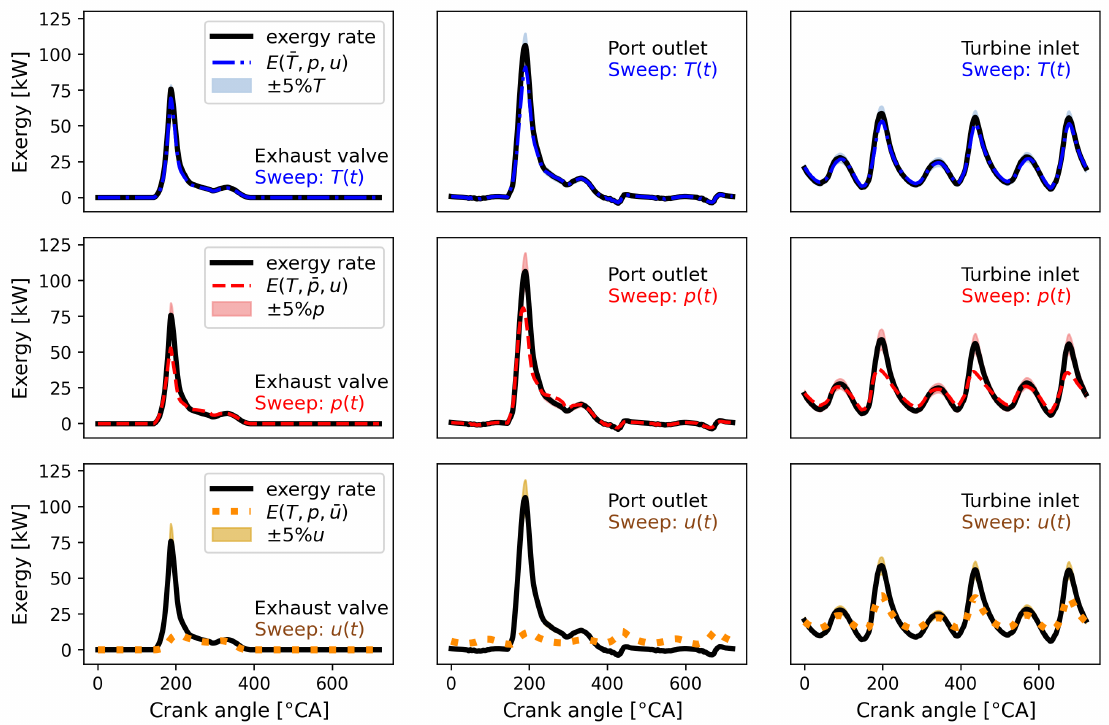
Figure 12. Exergy rates (unit: kW) at the turbine inlet and operating at test point (b) 900 rpm/11.5 nIMEP. From top to bottom, the shaded area in each subplot shows the deviations in enthalpy and exergy pulses caused by the variations in T , p , and u . The black curve represents the “true” exergy rates of the exergy pulsation as a reference, and the dashed curves are results of using the cycle-averaged values of each corresponding flow